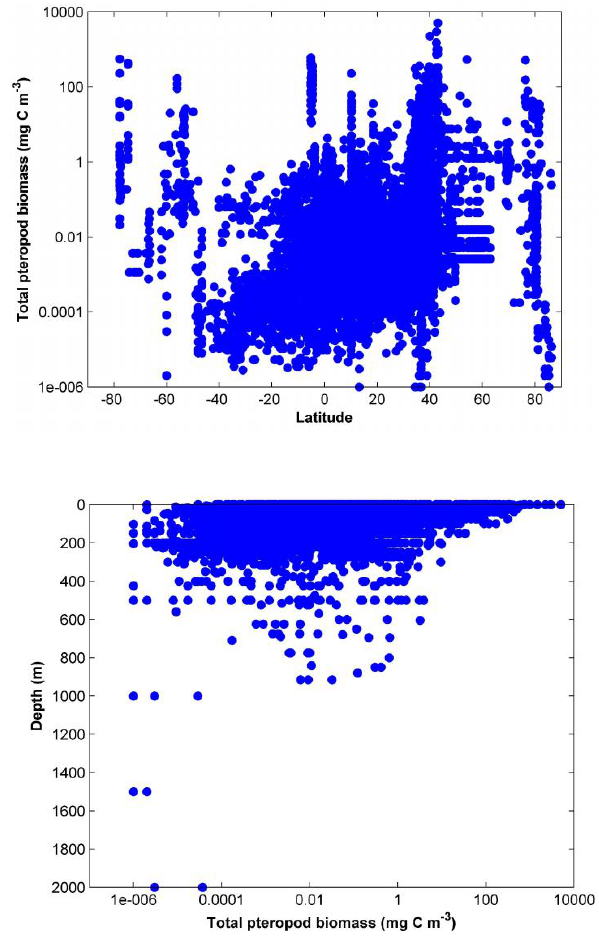
Figure 8. (Above) the distribution of pteropod biomass (mgCm − 3 ) Figure 8: Above: The distribution of pteropod biomass (mg C m -3 ) as a function of998 as a function of latitude; (below) the relationship between pteropod biomass and net-capture latitude; (below) the relationship between pteropod biomass and net-capture depth.999